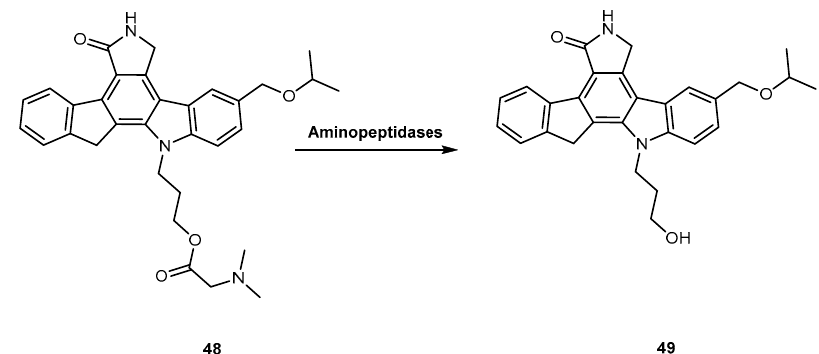
Figure 22. Bioconversion of amino acid ester prodrug 48 to its parent drug 49 by aminopeptidases (Reproduced from [4]).